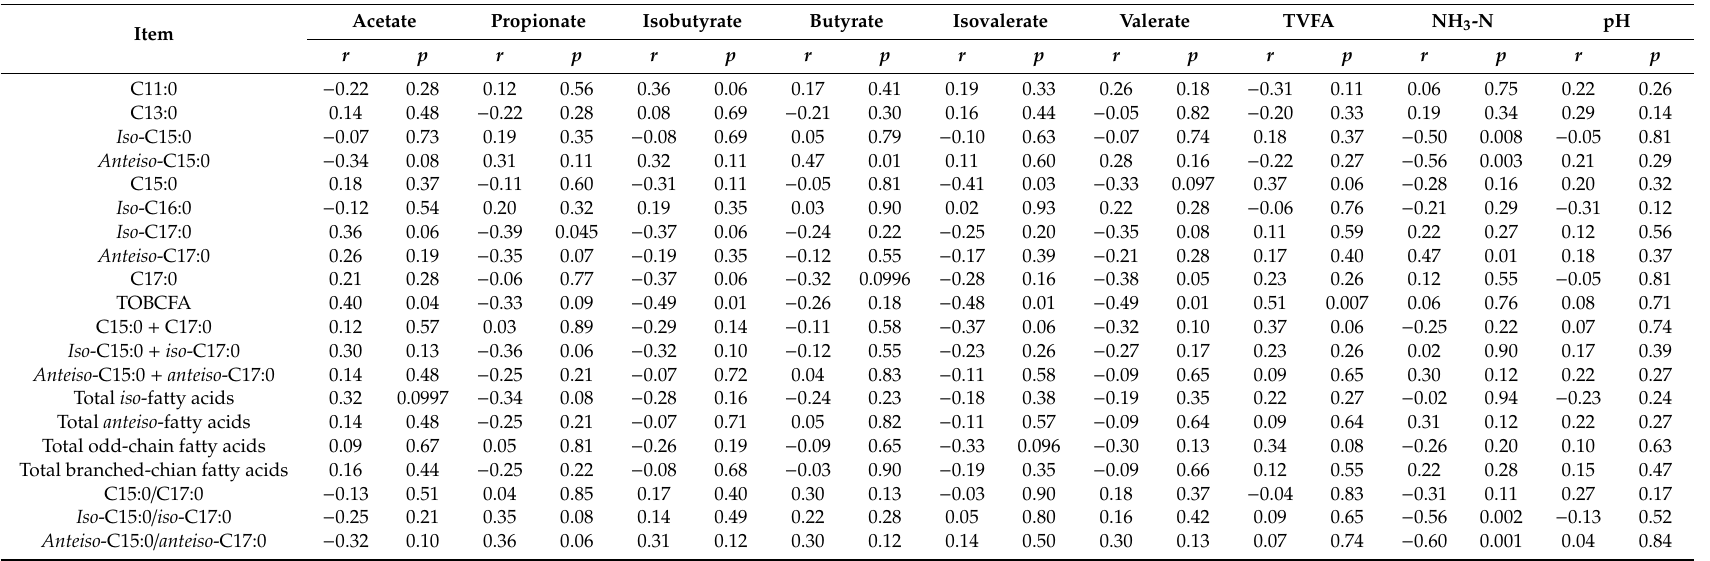
Table 6. Correlation between ruminal fermentation parameters and milk OBCFA